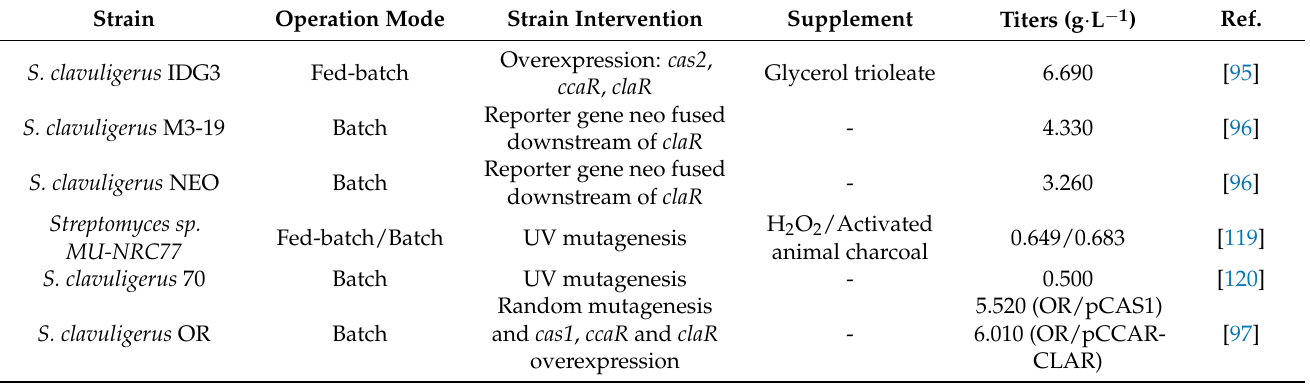
Table 1. Studies reporting the highest CA production with engineered S. clavuligerus